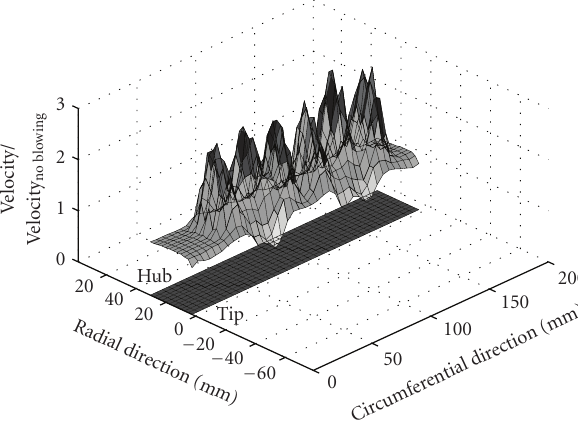
Figure 3: Measured velocity profile at relative axial location of first rotor face for steady injection with two injectors at 14.8% of stall mass flow through section incorporating 1/12 of unwrapped com- pressor annulus